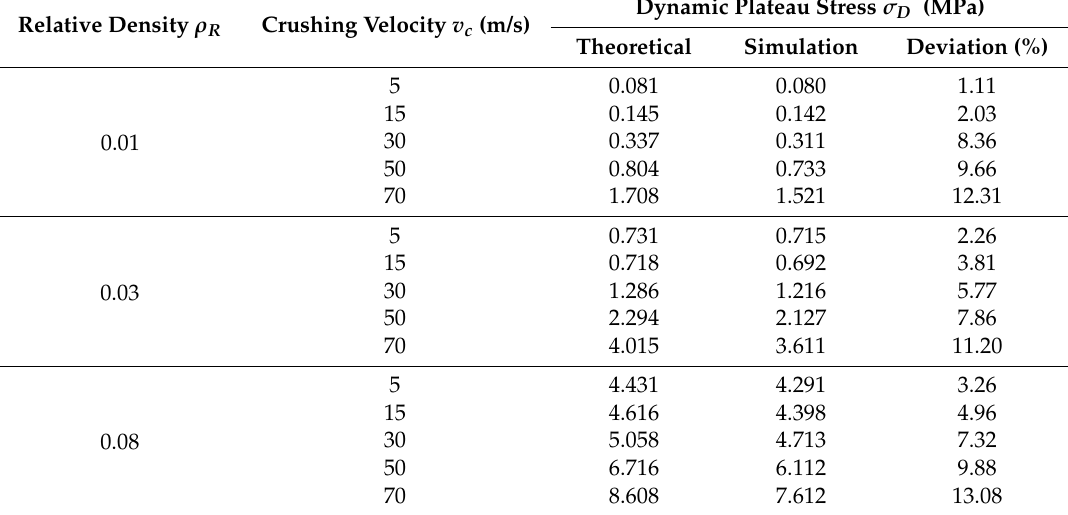
Figure 10. The quasi-static plateau stress σ 0 and the densification strain ε D with respect to relative density. Table 1. Dynamic plateau stress σ D from numerical simulation and theoretical prediction using Equations (2)–(4).